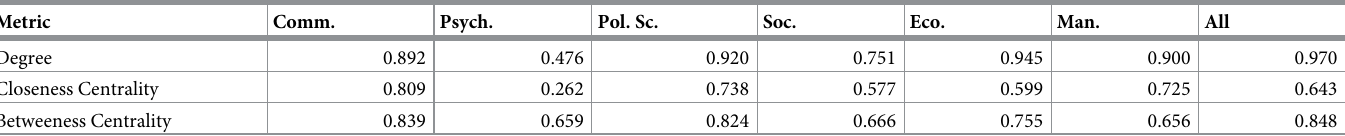
Table 8. Correlation between the number of scholars from each institution and the network metrics of the projection of institutions for each field and for the over- all network. Metric Comm.